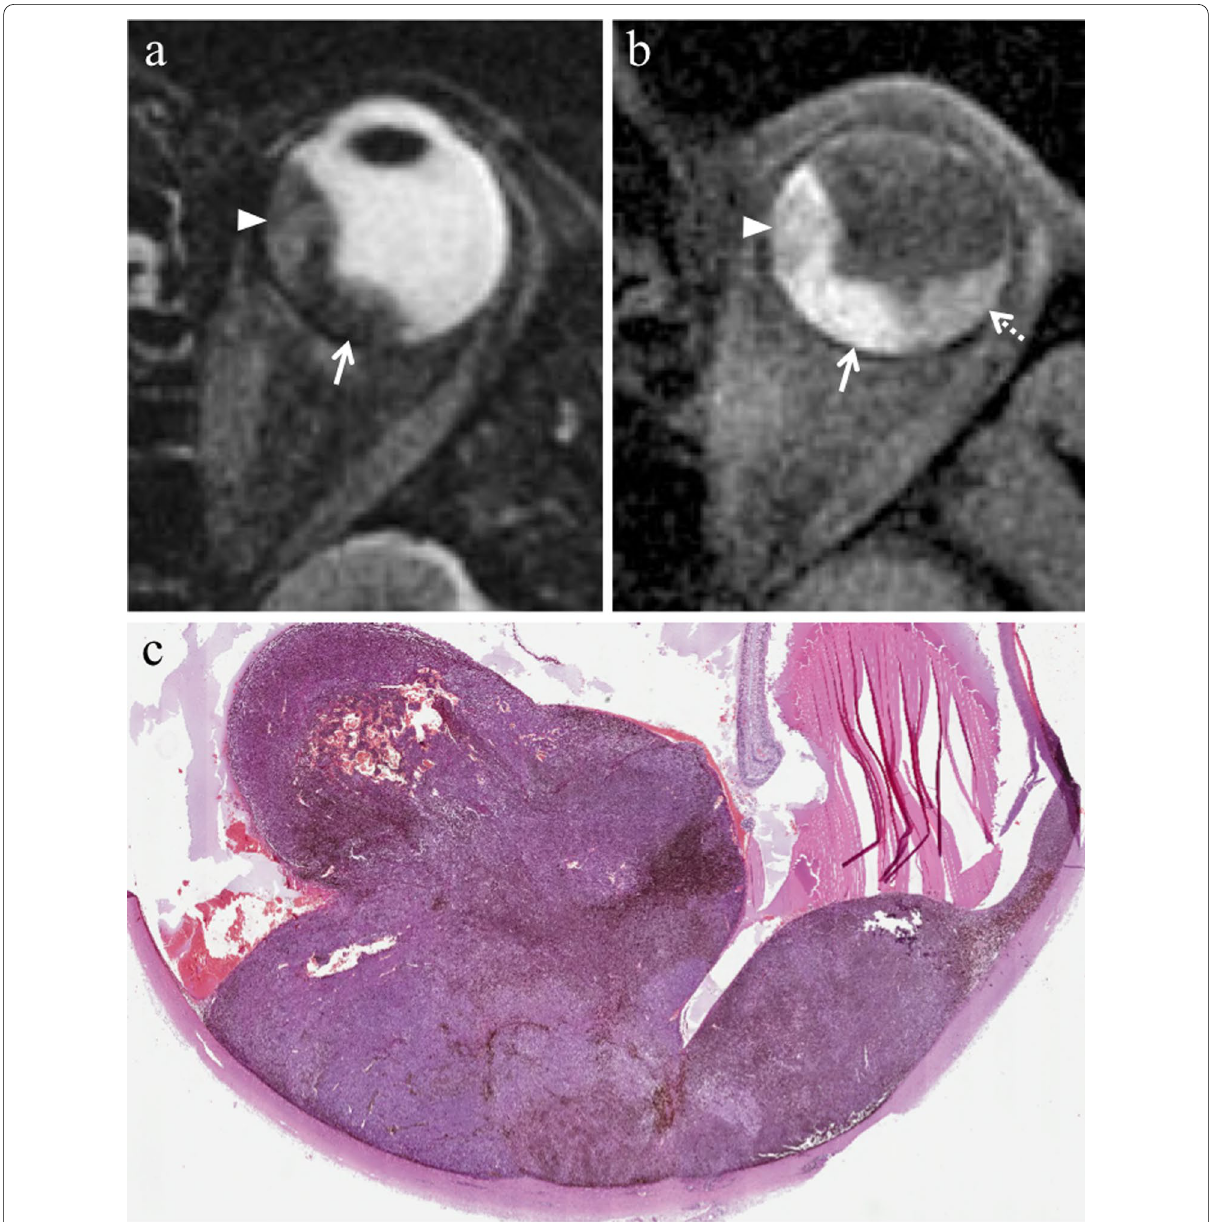
Fig. 9 A 55-year-old man with a bipartite choroidal melanoma of the left eye. Axial ( a ) T2-weighted turbo spin-echo STIR and ( b ) fat-suppressed T1-weighted images show an intraocular bilobate mass with bipartite pigmentation along the postero-medial aspect of the globe. The medial portion of the lesion (white arrowheads) exhibits intermediate signal intensity on both T2- and T1-weighted images, whereas the posterior portion (white arrows) demonstrates predominantly low signal intensity on T2-weighted image and high signal intensity on T1-weighted image, due to melanin pigmentation. Laterally to the lesion a retinal detachment is better depicted on fat-suppressed T1-weighted image (white dotted arrow in b ). ( c ) Histological examination: low magnification confirming the bilobate morphology of the melanoma, consisting of a less pigmented medial portion (on the left) and a more pigmented posterior component (on the right) (H&E, original magnification ×